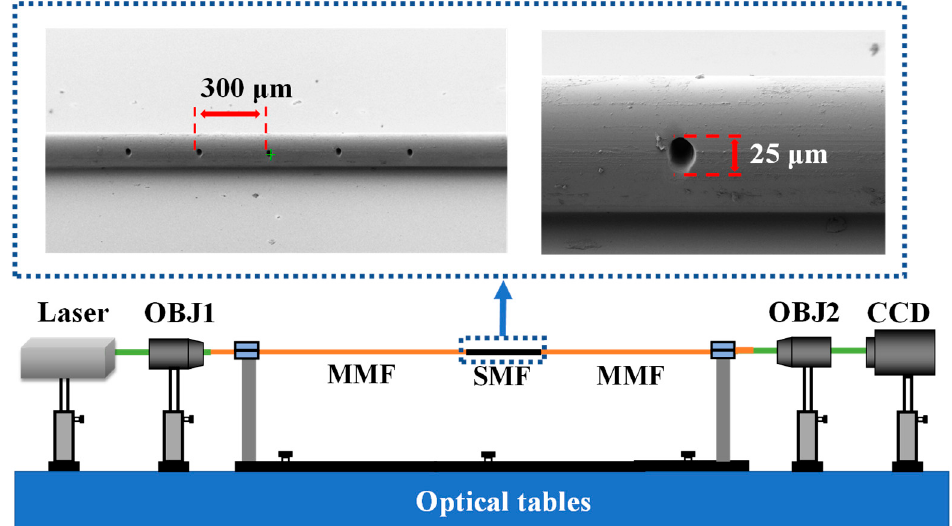
Figure 2. Experimental setup of the proposed fiber specklegram refractive index sensing system. CCD: charge-coupled device camera; OBJ: objective; MMF: multimode fiber; SMF: Single mode fiber.